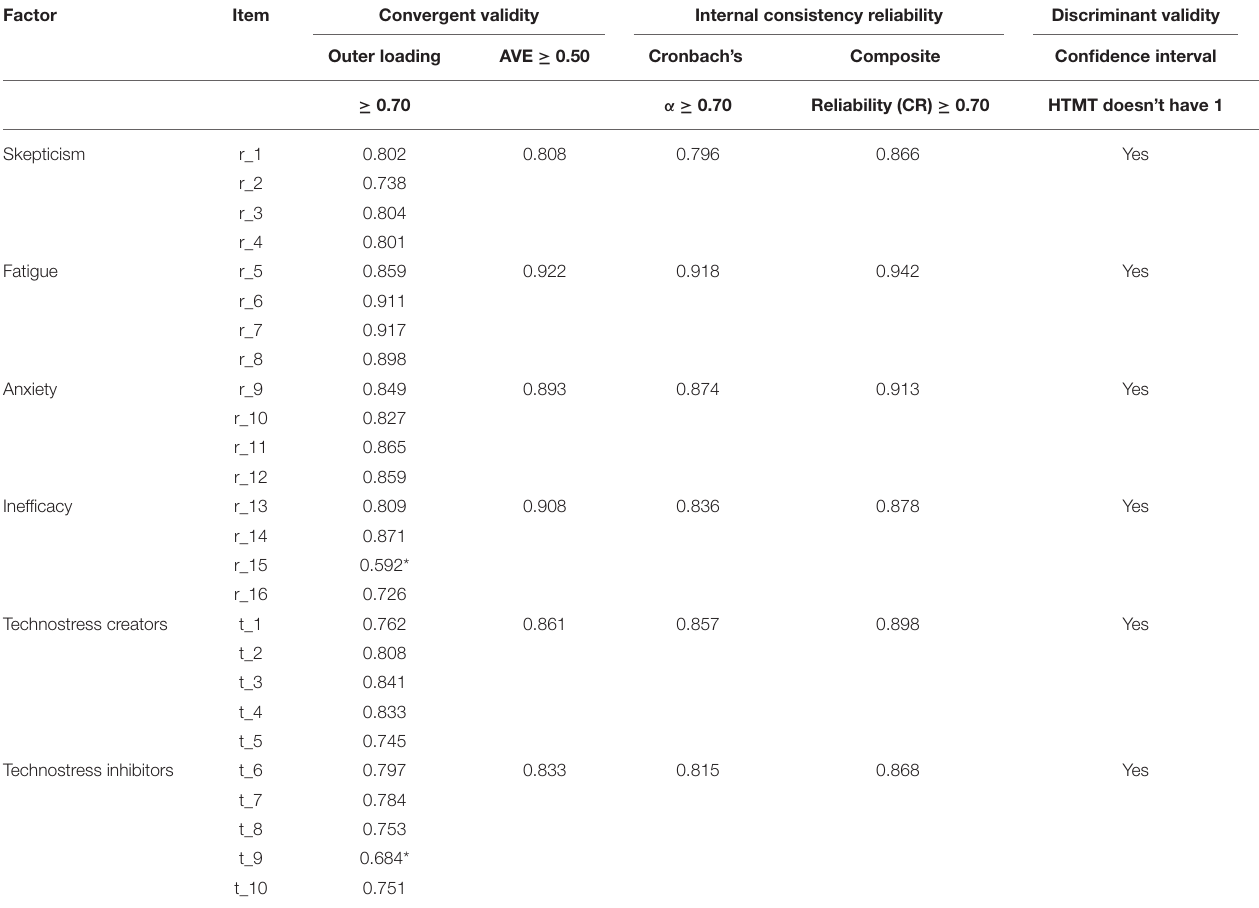
TABLE 3 | Results of reflective measurement model evaluation.